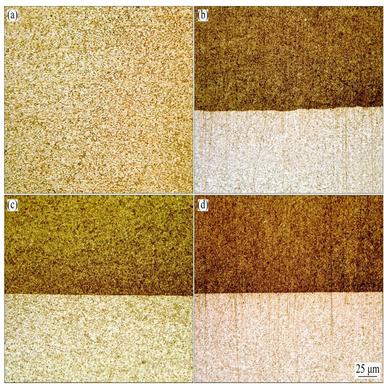
ptical micrographs of Ti−6Al−4V alloy (a) and interface of coatings (b−d) at different rotational speeds: (b) 600 r/min; (c) 800 r/min; (d) 1000 r/min